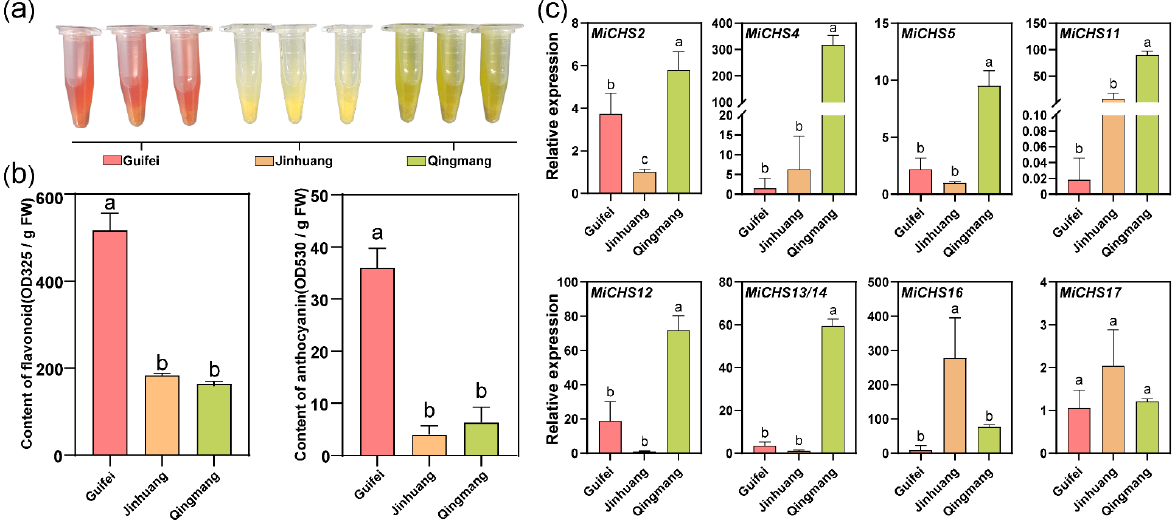
Figure 5. ( a ) Extraction solutions for flavonoid and anthocyanin in ‘Guifei’, ‘Jinhuang’ and ‘Qingmang’ ripe fruit peels. ( b ) Flavonoid and anthocyanin contents in the ripe fruit peels of three mango cultivars. ( c ) MiCHS genes expression levels in ‘Guifei’, ‘Jinhuang’ and ‘Qingmang’ fruit peels. The data represent the mean value ± SD, n = 3. Different letters above the bar chart indicate a significant difference at p < 0.05.